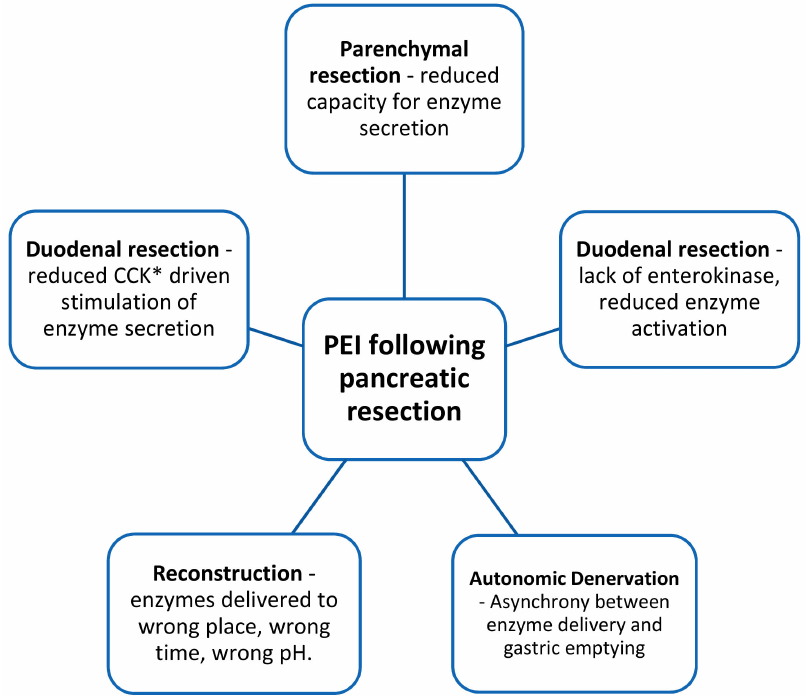
Figure 1. Factors contributing to PEI following pancreatico-duodenectomy. *CCK = cholecystokinin. Symptoms of PEI include pain, bloating, frequency, urgency, diarrhoea, fatty stool, flatulence, loss of appetite, nausea and vomiting and are physically and mentally